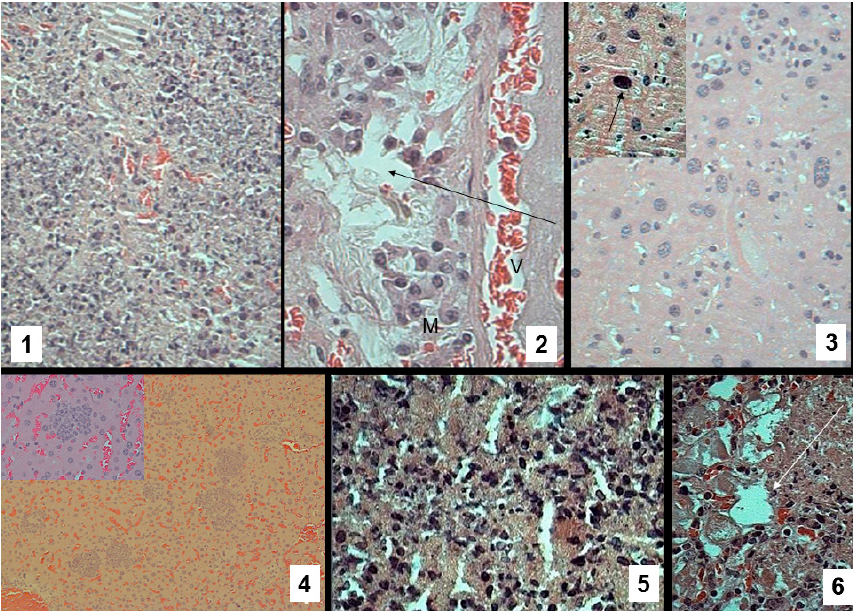
Figure 8. Pathomorphological data (hematoxylin and eosin (H&E) stain): 1 —lung, 20th day of TB, degree of macroscopic drug damage (DLD) = 3.75, group MPs + PCZ i.p. , objective 40×; 2 —same animal, lung, 80×, near blood vessel (V) collection of macrophages (M) and presumable deposit of particles ( arrow ) ; 3 —liver, 18th day of TB, DLD = 3.25, group PCZ per os , 80×, typical TB involvement; on top left insertion, same animal, nuclear changes ( arrow ) typical for PCZ toxic effect; 4 —liver, 18th day of TB, DLD = 3.75, group MPs-IgG + PCZ i.p. , 10× (insertion 40×), granulomas, but no degenerating cells were found; 5 and 6 —same animal as 1 and 2 , lung TB, 5 —objective 80×; 6 —deposit of particles ( arrow ) in TB focus.